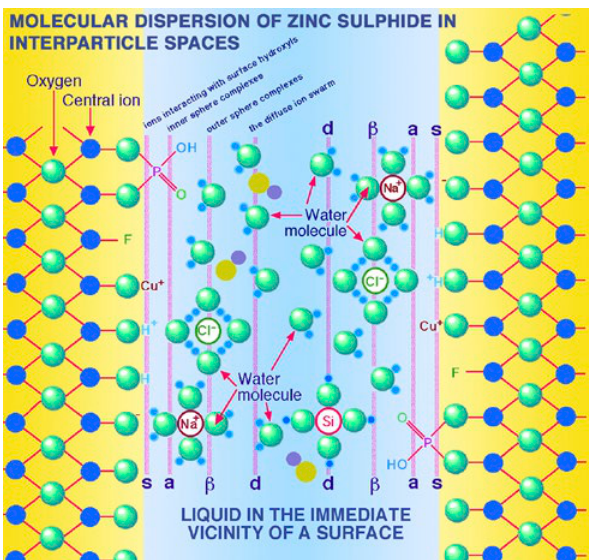
Figure 74. The chemical reaction between hydrogen sulphide ions in pore fluids and trace metal ions adsorbed on sediment particle surfaces “liberates” metal sulphide molecules into the fluid phase. Diffusion controls the rate at which the exceedingly dilute disper- sion of molecular zinc sulphide species (represented as tan and blue-grey dots) can begin to nucleate to the solid phase. Nucleation of a critical cluster develops as a particle at maximum surface ener- gy. This dissociates water and combines with it chemically (chem- isorbs) to form a hydroxy-sulphide.